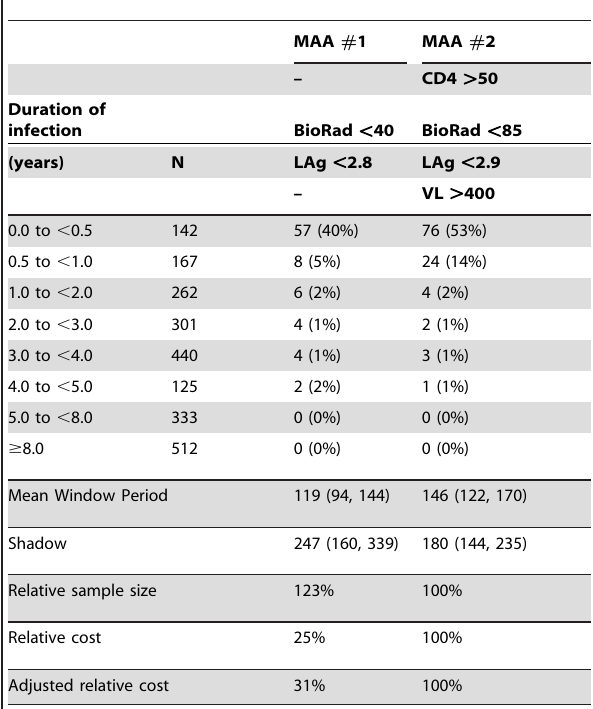
Table 3. Performance characteristics of optimized MAAs that include the LAg-Avidity